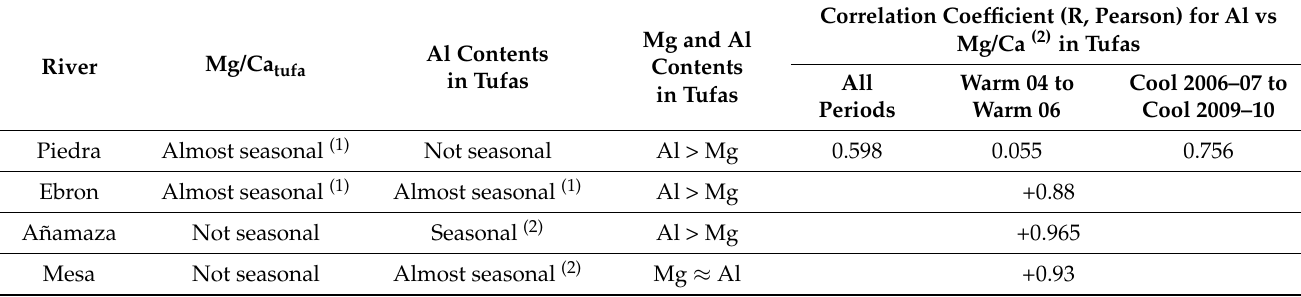
Table 3. Trends and correlations for some analytical parameters of studied tufa